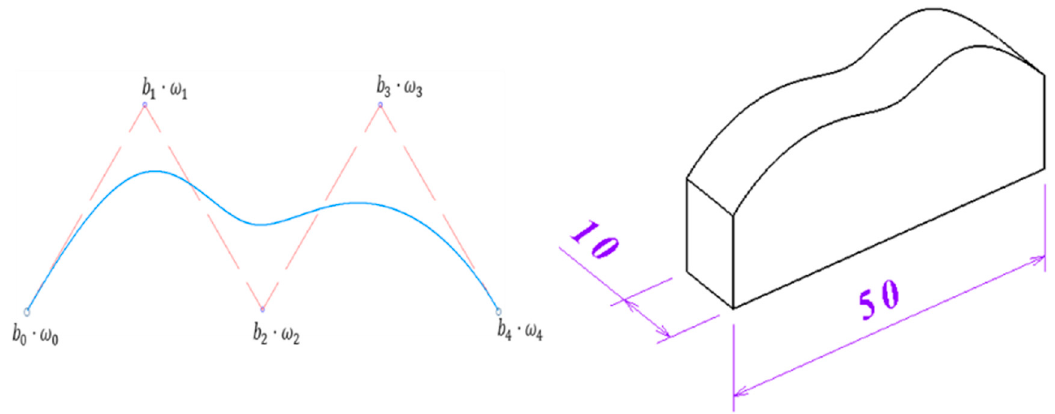
Figure 6. The NURBS (Non-uniform rational b-spline) curved and mechanical model.